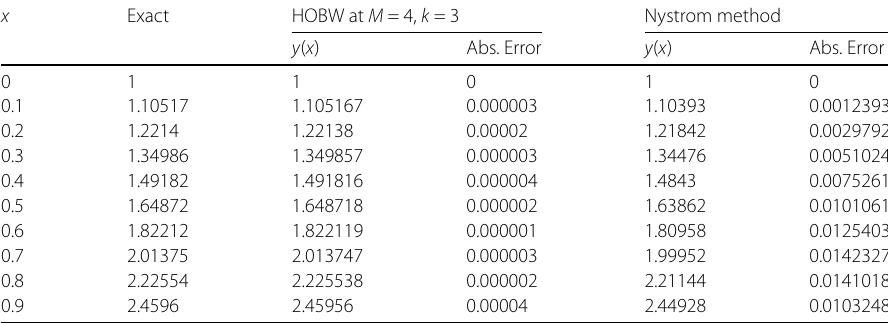
Table 3 Comparison of HOBW results and the Nystrom method for Example 7.3